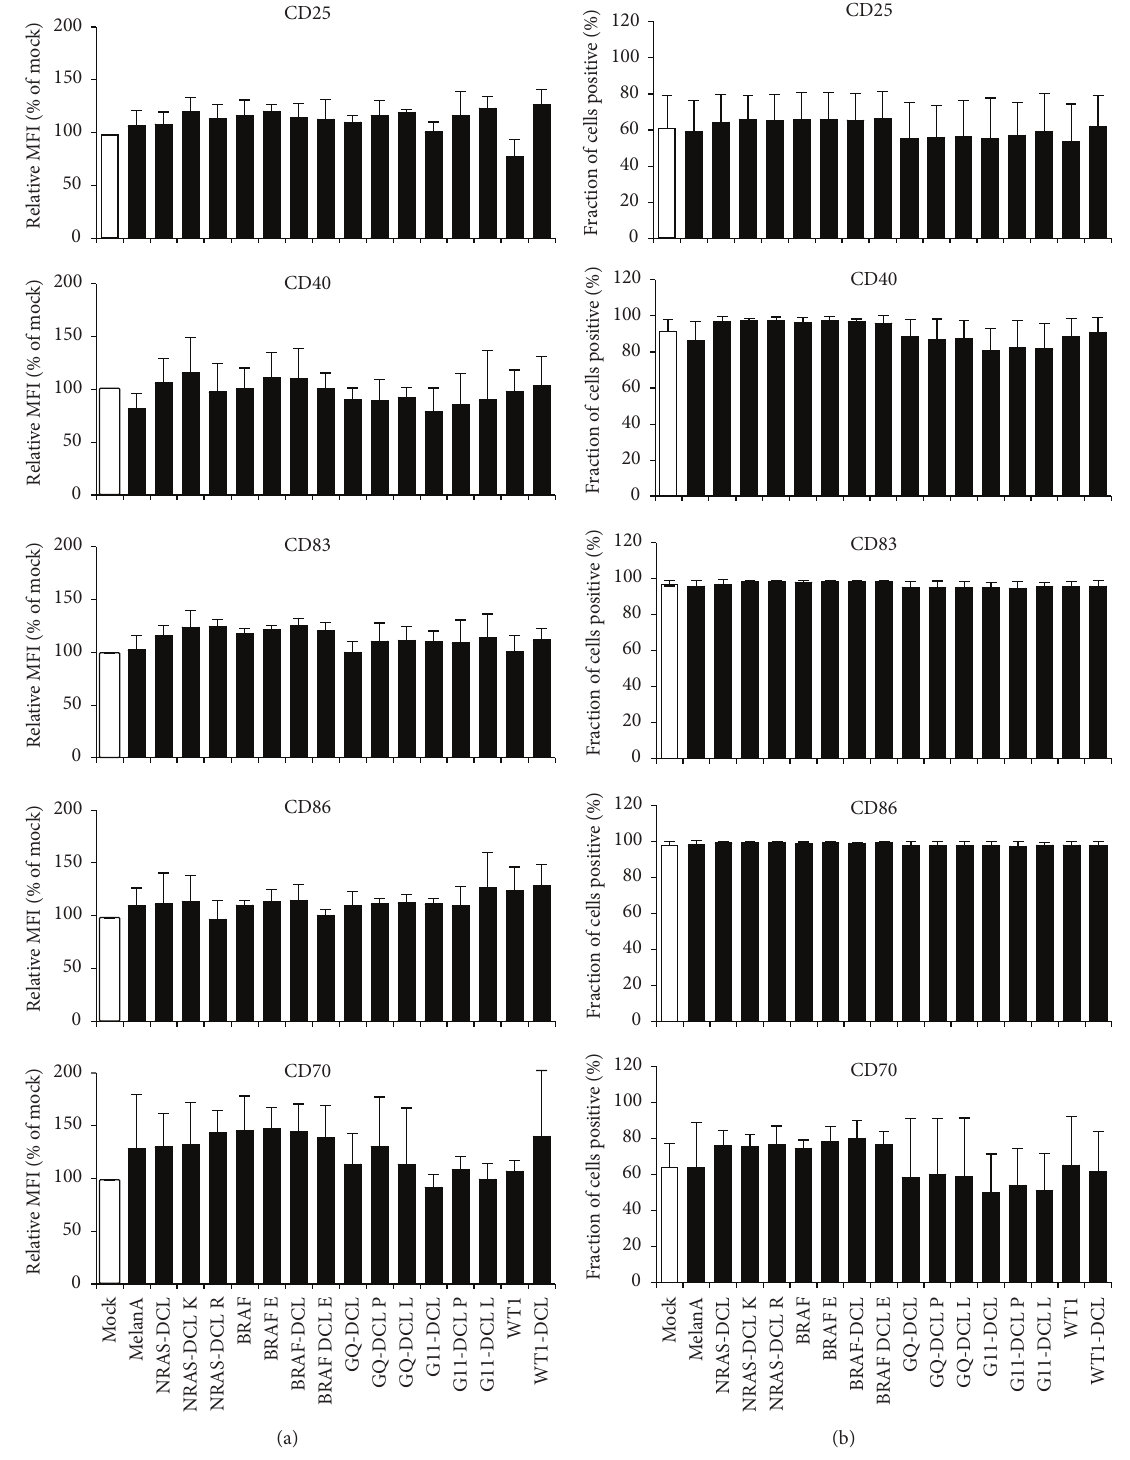
Figure 2: No difference in phenotype between mock- and mRNA-electroporated DCs. DCs were either electroporated without RNA (Mock) or a panel of 16 RNAs encoding different tumor antigens, either mutated or not and either linked to the lysosomal targeting signal DC-LAMP or not (see Table 1). Twenty-four hours after electroporation, the surface expression of CD25, CD40, CD86, CD70, and CD83 was determined by flow cytometry. Surface marker expression of mock-electroporated DCs was put at 100% and marker expression after electroporation of the mRNAs was put in relation to that (a), or percent positive cells are shown (b). Shown are averages of at least 3 independent experiments. Error bars indicate the standard deviation (SD). According to a 1-way ANOVA with multiple comparison test, no statistically significant differences were present within the surface staining data ( 𝑝 > 0.05